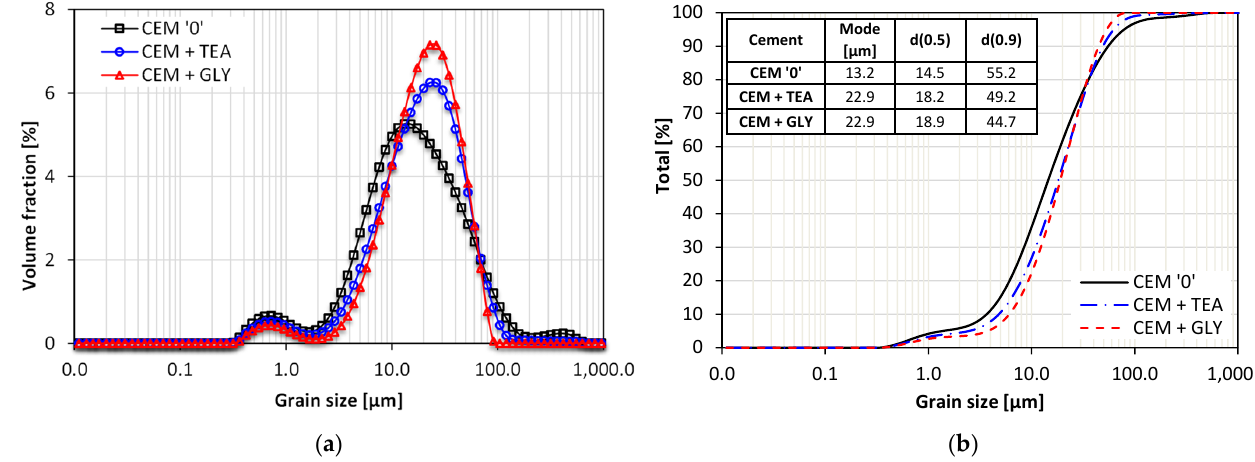
Figure 2. Grain size distribution of cements: ( a ) differential and ( b ) cumulative curves.